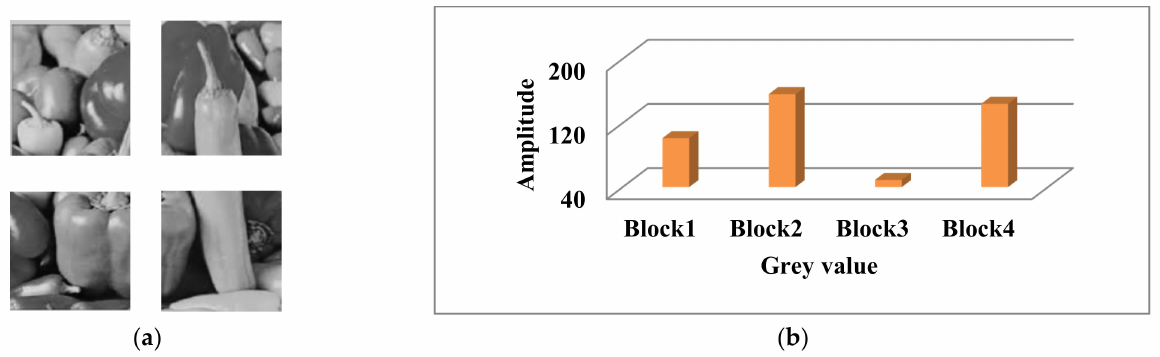
Figure 7. ( a ) cover image, and ( b ) histogram bins of the cover image. Step 2 : The 256-bit key is generated using Equation (4) based on the histogram bin value, and secret data are encrypted using a 256-bit key. Step 3 : The cover image is partitioned into 4 blocks, and a histogram is drawn for each, as shown in Figure 8a,b.